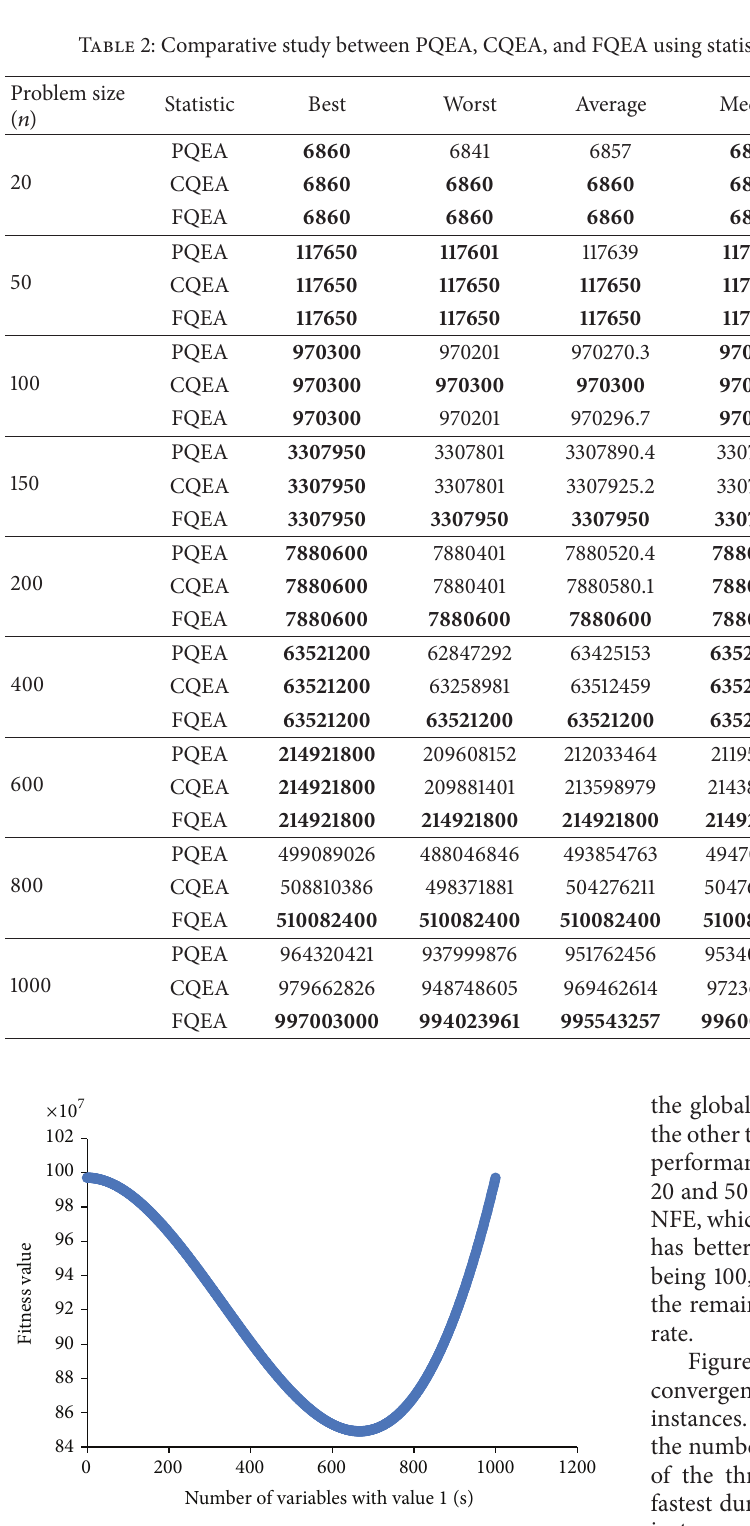
Figure 4: COUNTSAT function with 𝑛 being